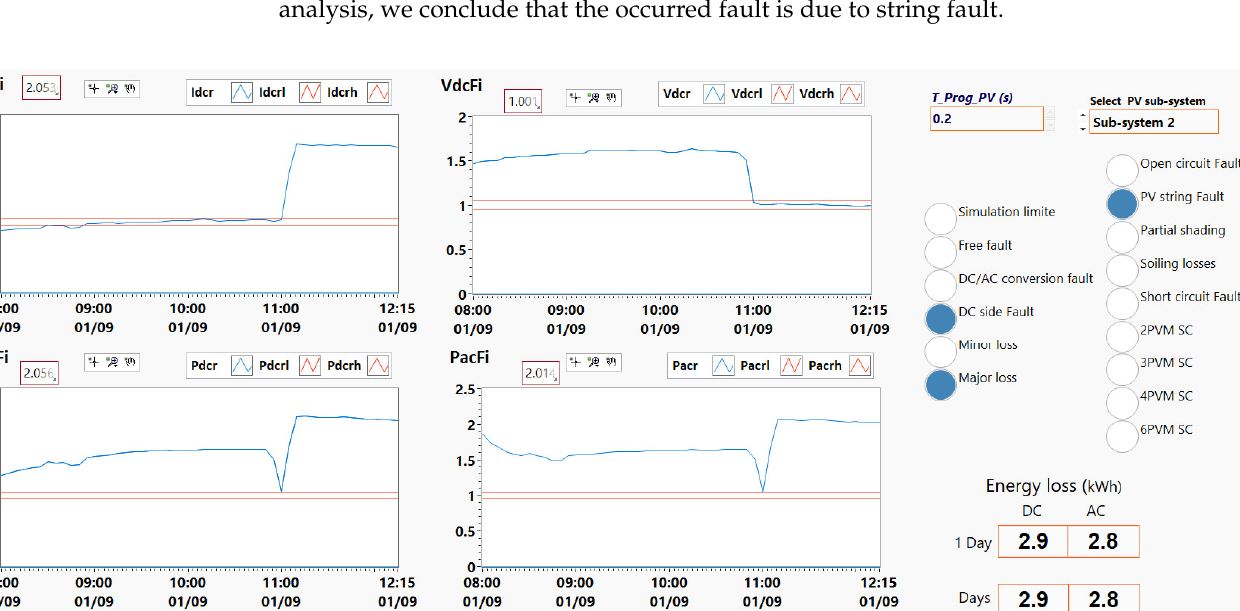
Figure 28. Recognition of open circuit fault in PV subsystem 2.